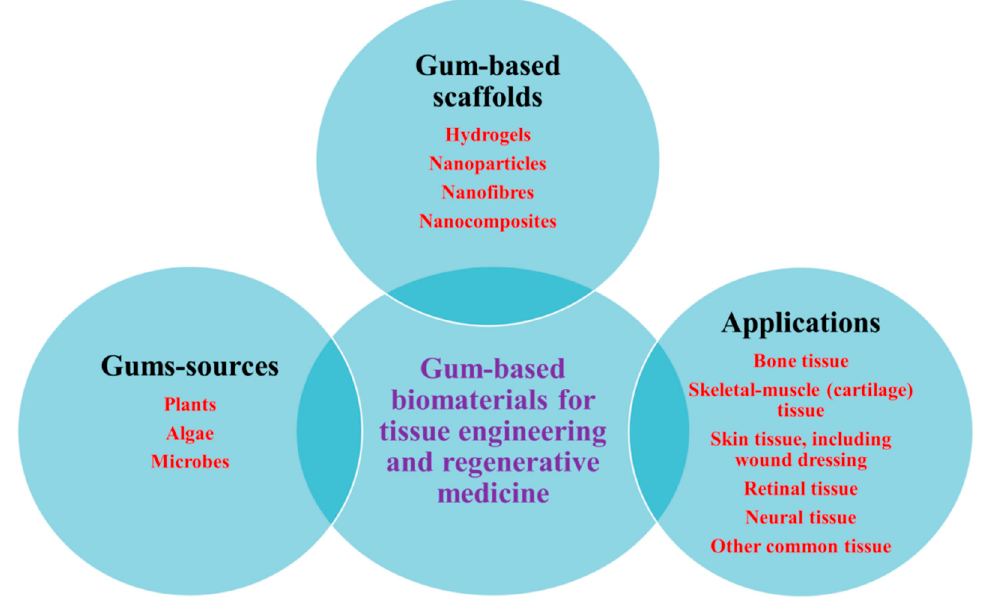
Figure 2. Schematic drawing of gums sources, gums-based scaffolds and scaffold components, and their potential tissue engineering applications.